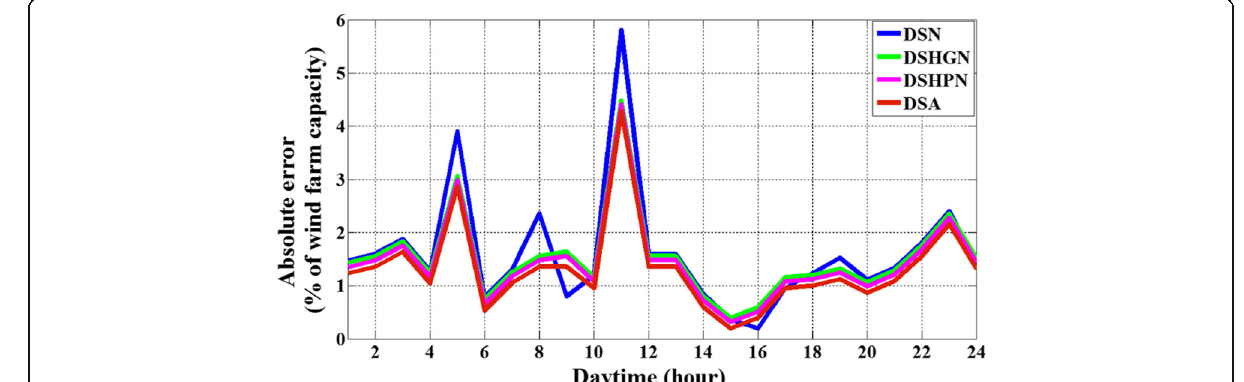
Fig. 8 Normalized absolute values of forecast errors for a winter day